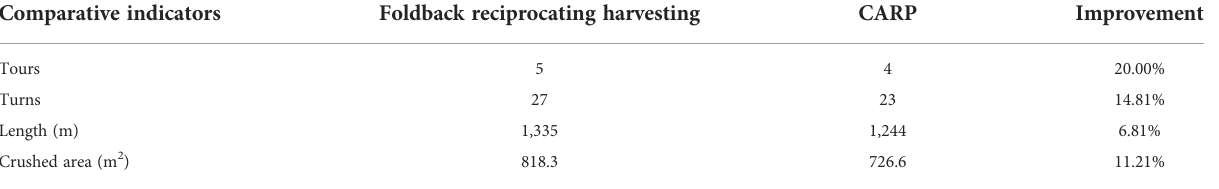
TABLE 7 Comparison of different harvesting methods for irregular fi